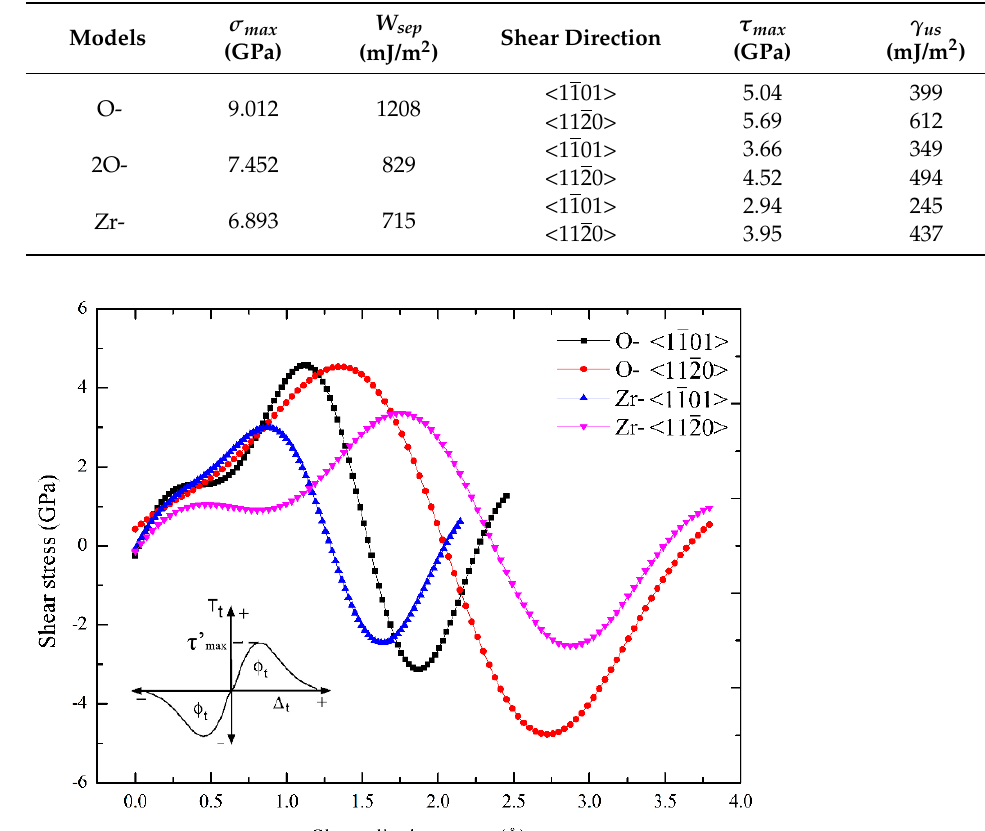
Table 1. The basic mechanical properties of the c-ZrO 2 (001)/ α -Al 2 O 3 (1102) interfaces, including the tensile strength ( σ max ), the work of separation ( W sep ), the shear strength ( τ max ), and the unstable stacking energy ( γ us ).